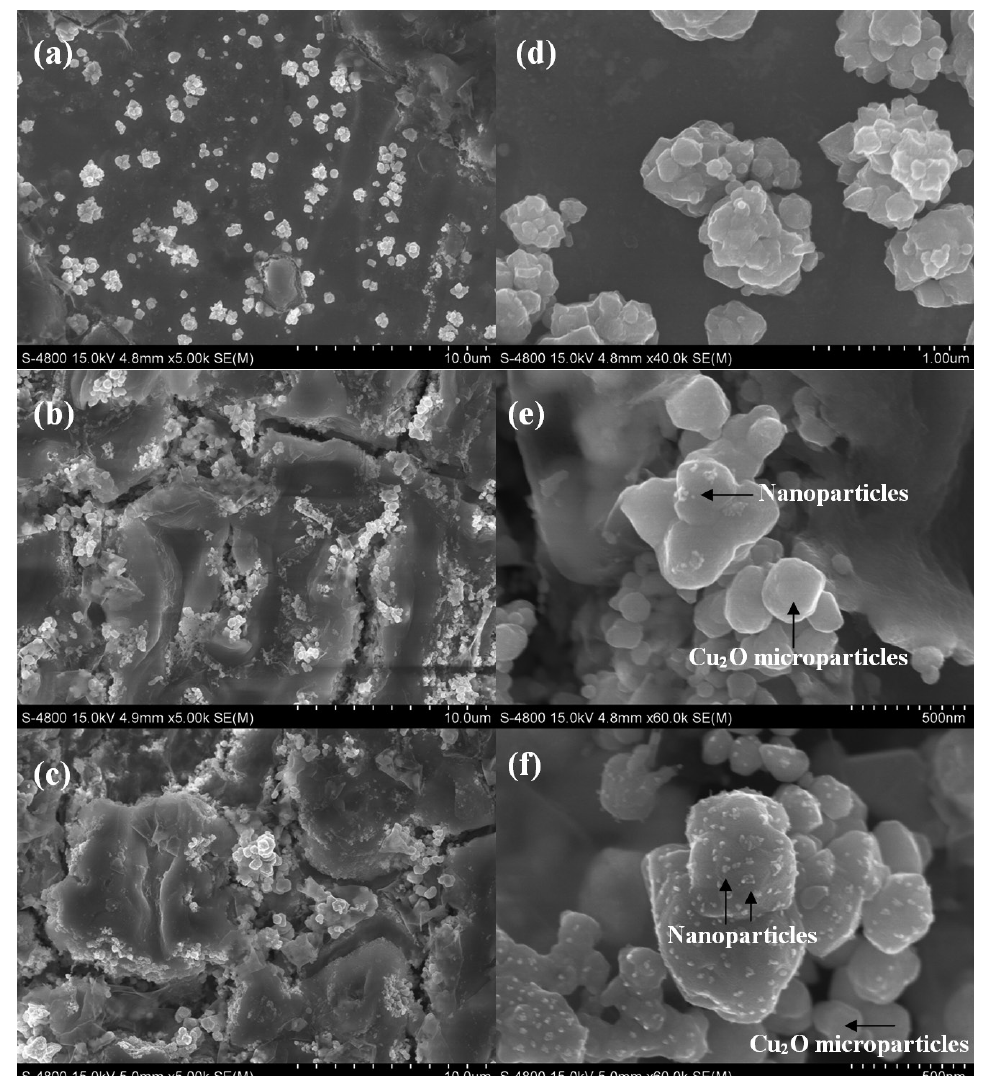
Figure 4. SEM micrographs of Cu O(x = 1,2)/amorphous compounds by etching Cu-Hf-Al amorphous alloys in 0.5 M HCl solution for x (a) 8 h, (b) 14 h, (c) 20 h. (d) ~ (f) show magnified images of (a) ~ (c),